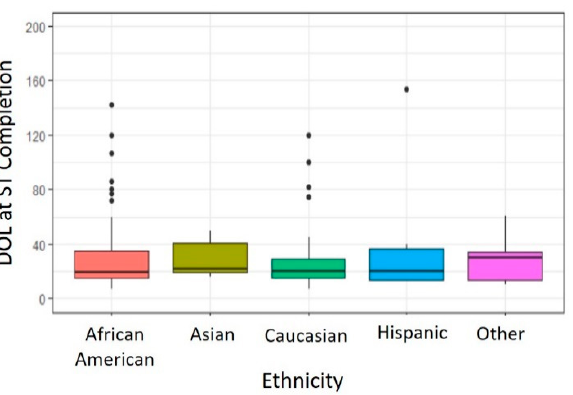
Figure 3. Effect of Ethnicity on Age at Successful Completion of Sweat Chloride Testing.